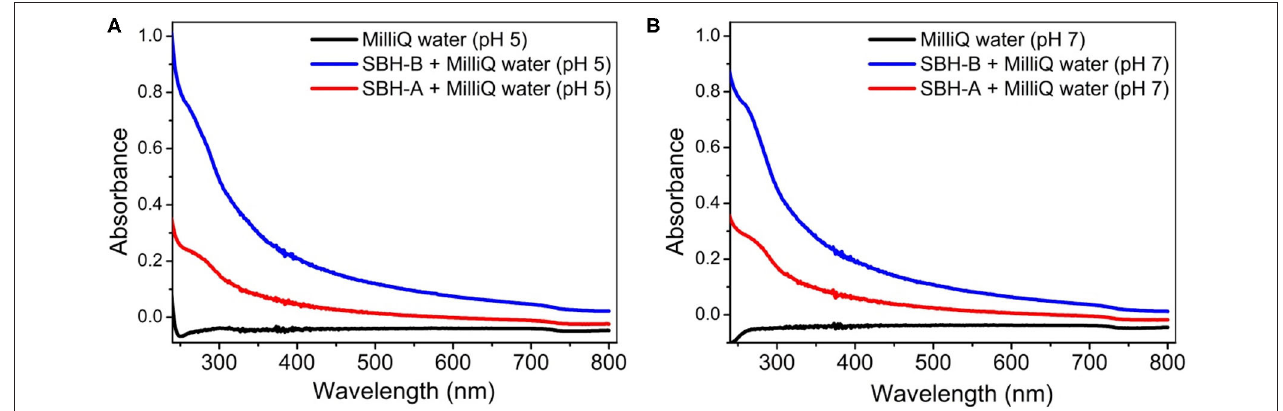
FIGURE 4 | UV-visible spectra of the solutions obtained after the release tests of SBH-A and SBH-B (1,600mg L − 1 ) in MilliQ ® water at pH 5 (A) and 7 (B) .